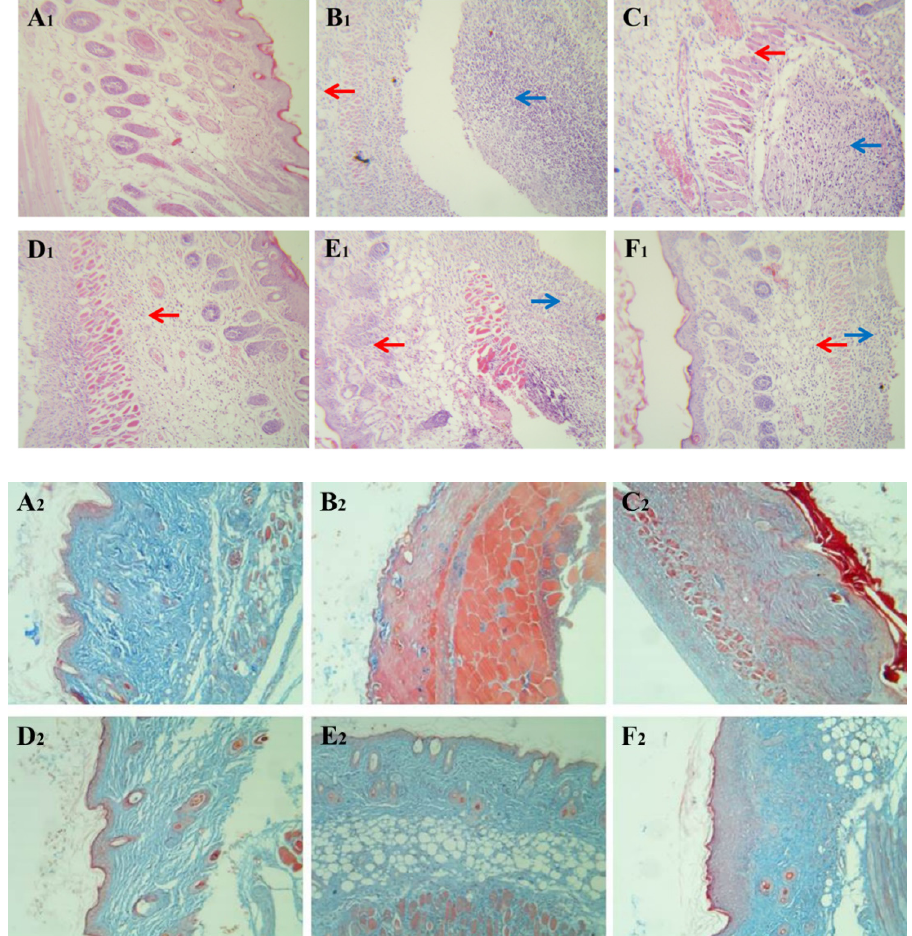
Figure 6. Effect of DPTM on pathological changes in MRSA infected skin (HE: 200×, Masson: 100×). These microscopic photographs of the wound healing skins were obtained from mice in the blank control group ( A 1 and A 2 ), positive control group ( B 1 and B 2 ), 1% DPTM ointment treatment group ( C 1 and C 2 ), 2% DPTM ointment treatment group ( D 1 and D 2 ), 2% retapamulin ointment treatment group ( E 1 and E 2 ), and 3% DPTM ointment treatment group ( F 1 and F 2 ). Red arrows point at inflammatory cell infiltration and the blue arrows point at inflammatory cell accumulation.